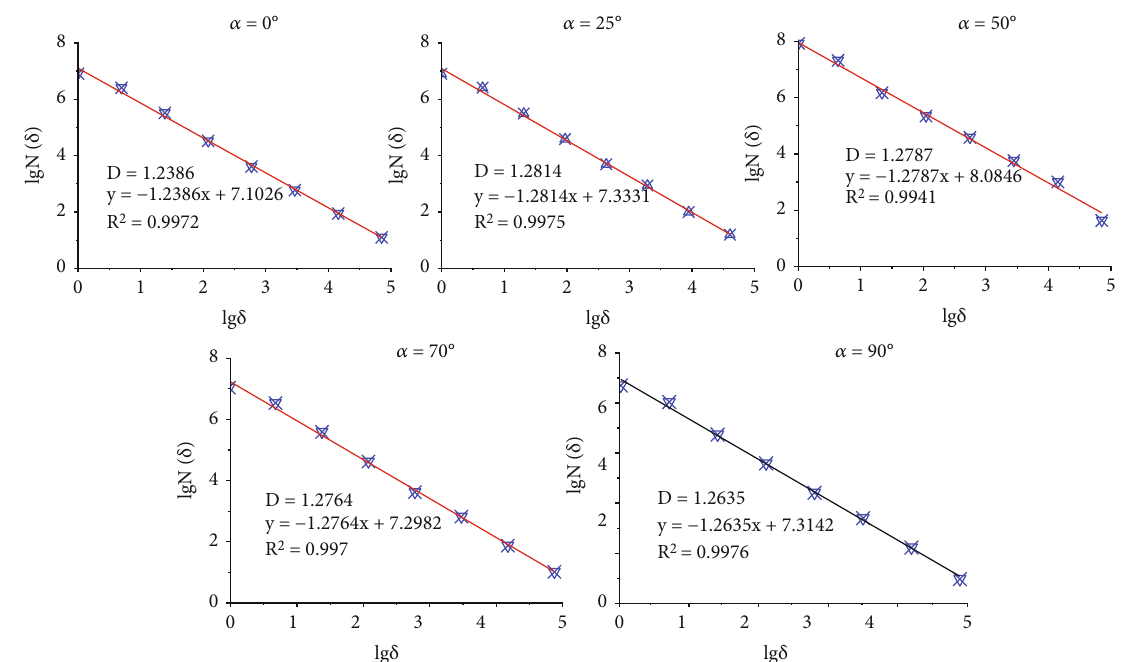
Figure 7: Calculation results of fractal dimension of cracks under di ff erent joint angles.